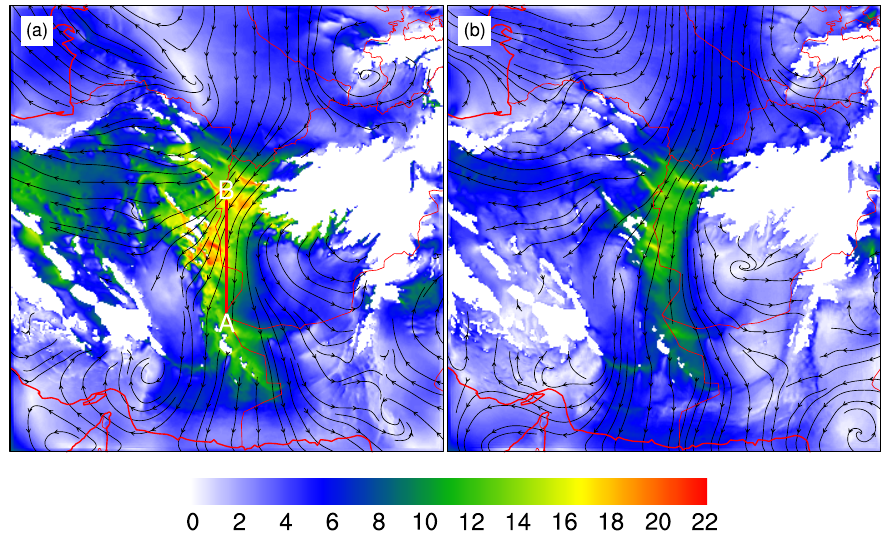
Fig. 3. Simulated wind speed (ms − 1 ) and streamlines at 800hPa at (a) 00:00 and (b) 12:00 local times averaged during July 2009. The line AB marks the vertical cross sections plotted in Fig.